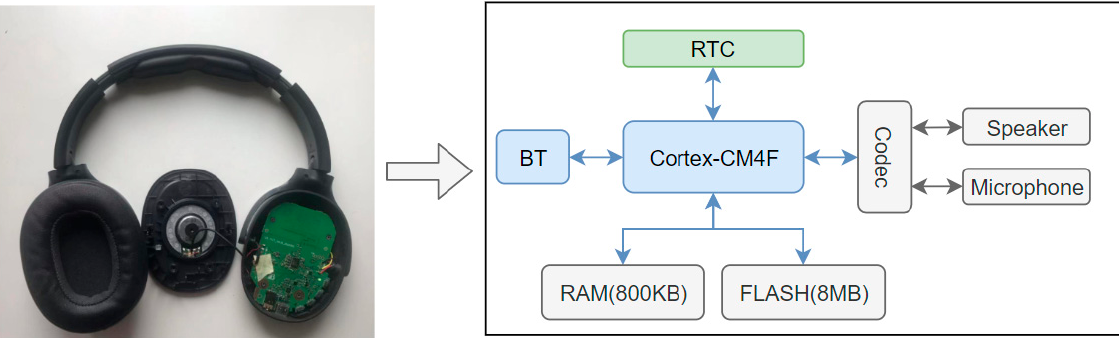
Figure 2. SL-PLD and Core-Board hardware